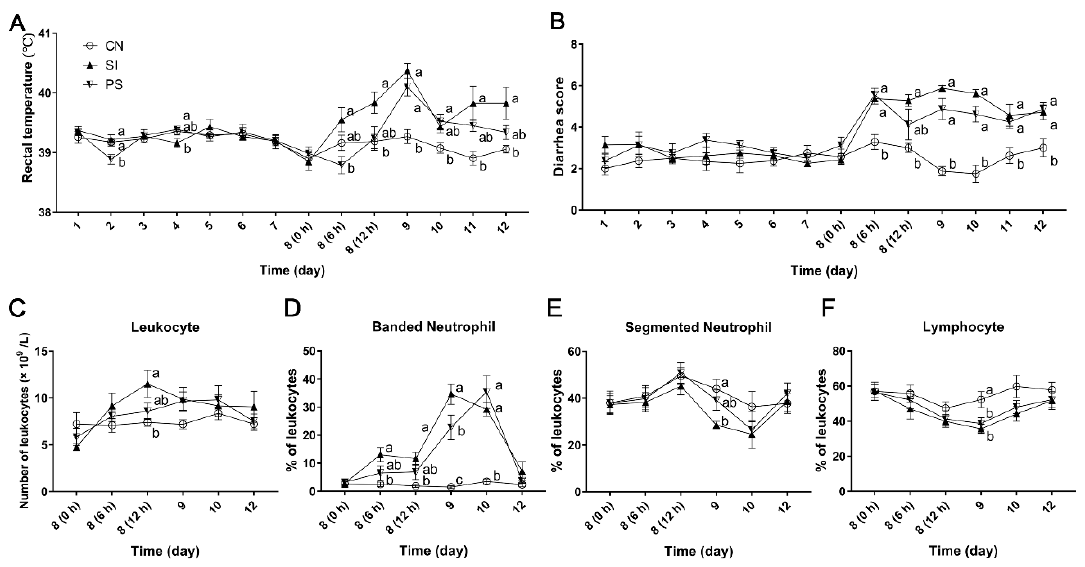
Figure 2. E ff ects of Lactobacillus johnsonii L531, Bacillus licheniformis BL1721 and Bacillus subtilis BS1715 (LBB-mix) on clinical signs and blood cell di ff erential counts of Salmonella Infantis infection. ( A ) Rectal temperature and ( B ) diarrhea scores in pigs ( n = 8 per group). ( C ) The total number of peripheral blood leukocytes. The percentage of banded neutrophils ( D ), segmented neutrophils ( E ), and lymphocytes ( F ) on blood leukocytes. Control group with sterile physiological saline (CN); oral sterile physiological saline from day 1 to day 7 followed by S . Infantis challenge on day 8 (SI); Pretreated with the potential probiotic mixture for day 1 to day 7 and followed by S . Infantis challenge on day 8 (PS). Mean values at the same time point without a common superscript ( a, b, c ) di ff er significantly ( p < 0.05).